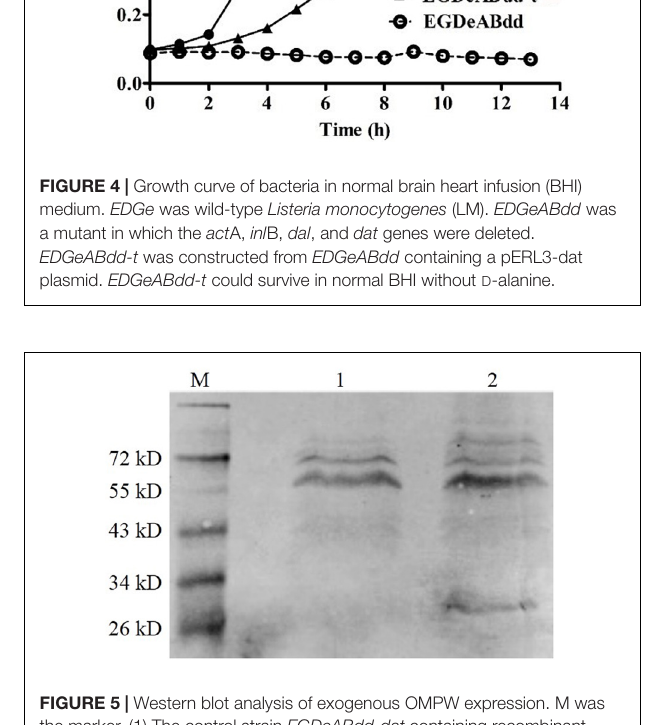
FIGURE 5 | Western blot analysis of exogenous OMPW expression. M was the marker. (1) The control strain EGDeABdd-dat containing recombinant plasmid pERL3-dat-tLLO. (2) The vaccine strain EGDeABdd-dat-ompW containing recombinant plasmid pERL3-dat-ompW. The fusion